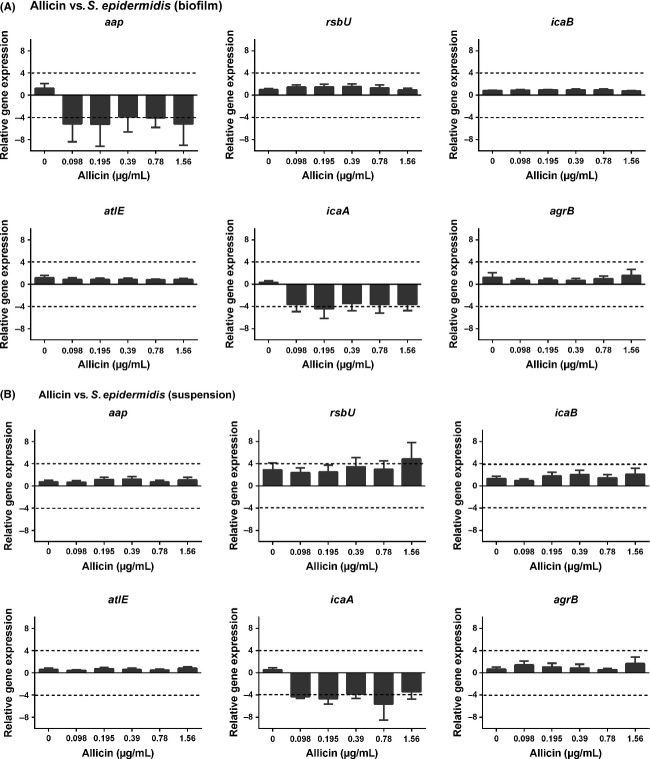
Relative mRNA expression (mean ± SEM) of selected biofilm-related genes in biofilm bacteria (A) and persister cells in suspension (B). Down- and upregulation of gene expression (marked by dashed lines) were considered significant when the relative expression was decreased or increased ≥4 folds.